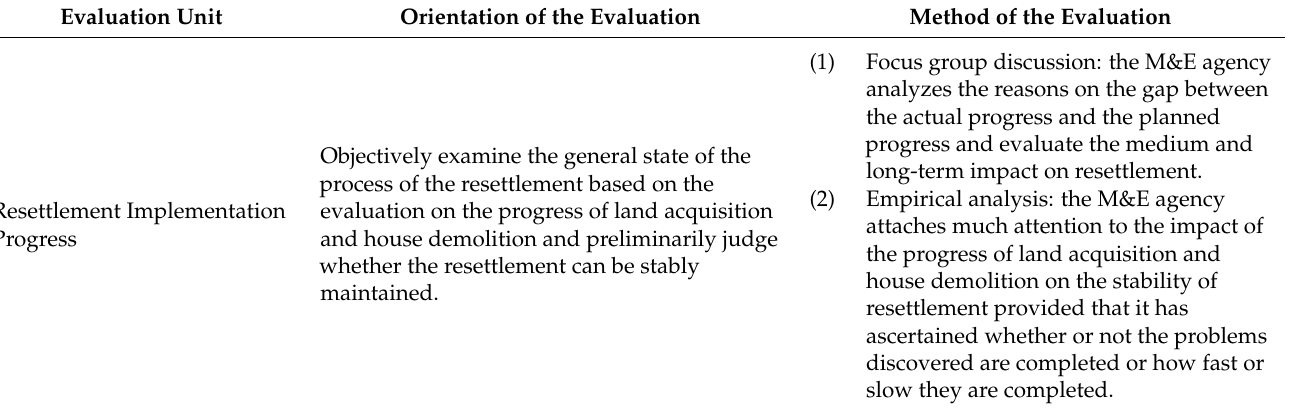
Table A2. Summary of the Evaluation of